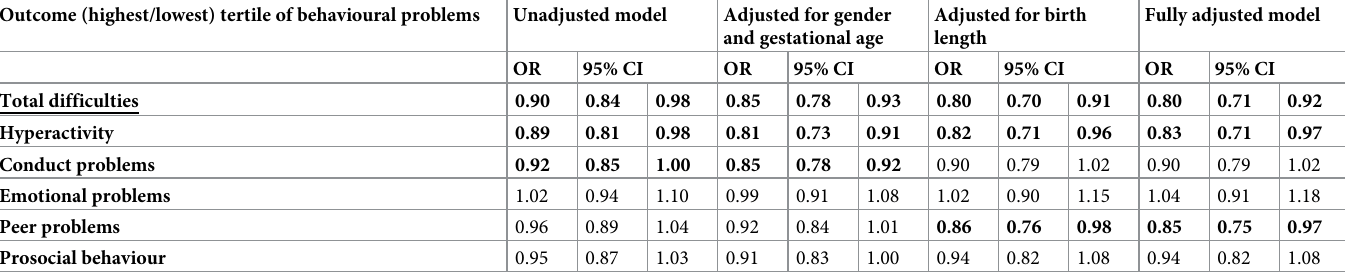
Table 4. Weighted models for the association of birth weigth and childhood behavioural problems measured using strength and dificulties questionnaires at age 7 in the Czech ELSPAC cohort. Outcome (highest/lowest) tertile of behavioural problems